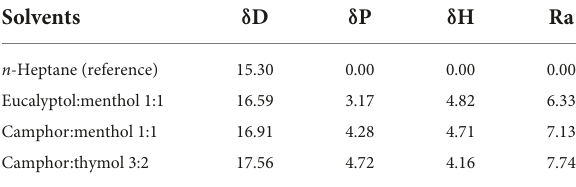
deep eutectic solvents (NaHDES).